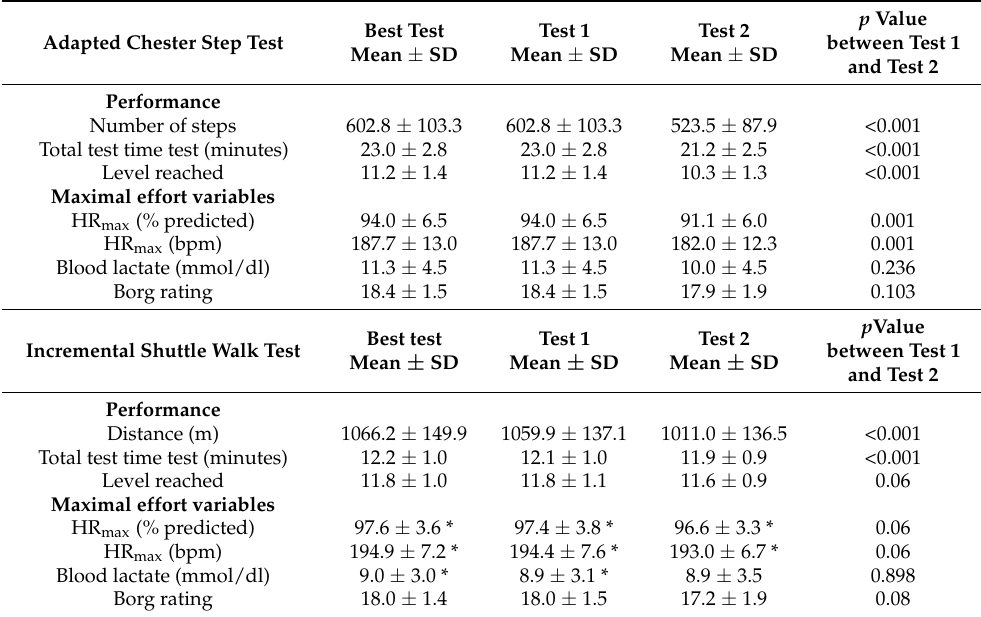
Table 2. Performance and maximal effort attainment results of the adapted Chester step test and incremental shuttle walk